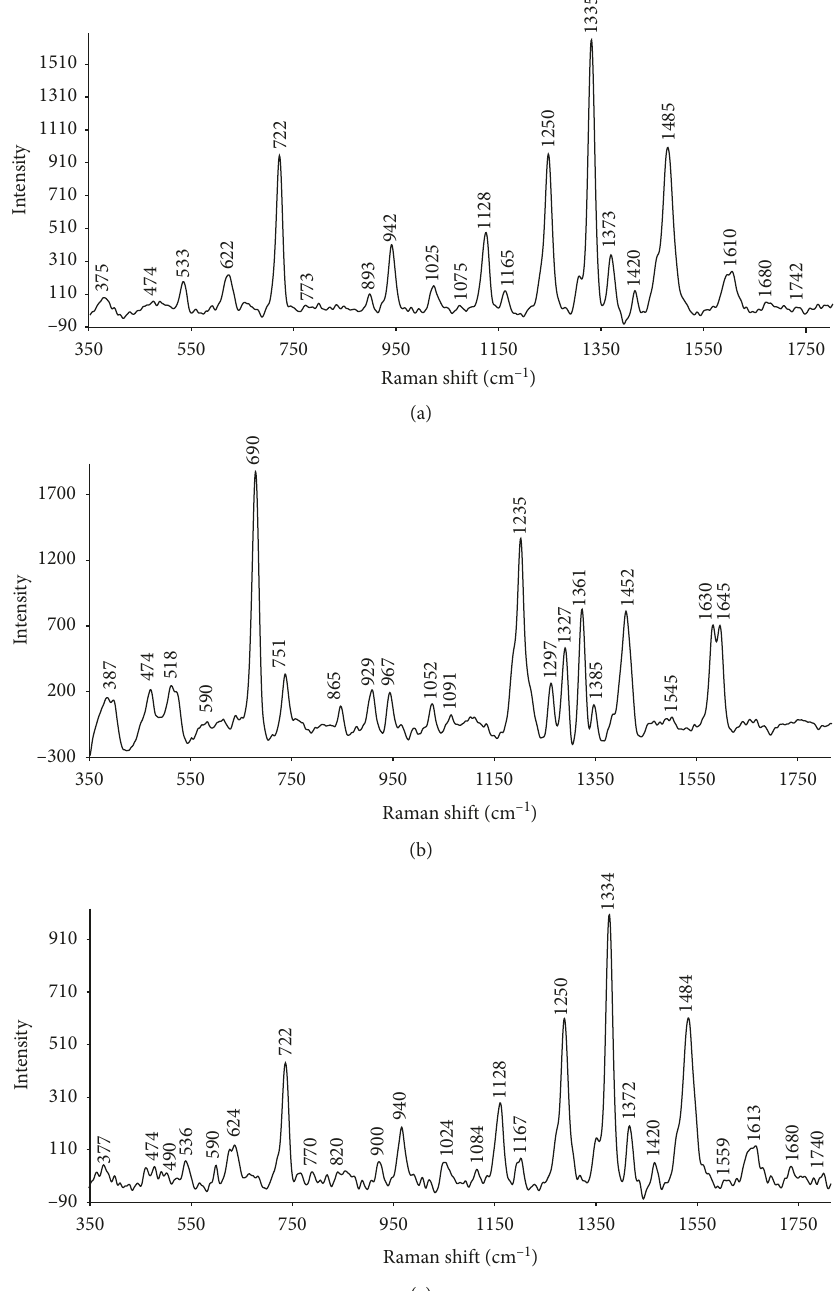
Figure 10: (a) Raman spectrum of aqueous solution of adenine at pH 7.0 (laser output: 633 nm, P aqueous solution of pyridoxine at pH 7.0 (laser output: 633nm, P pyridoxine at pH 7.0 (laser output: 633nm, P